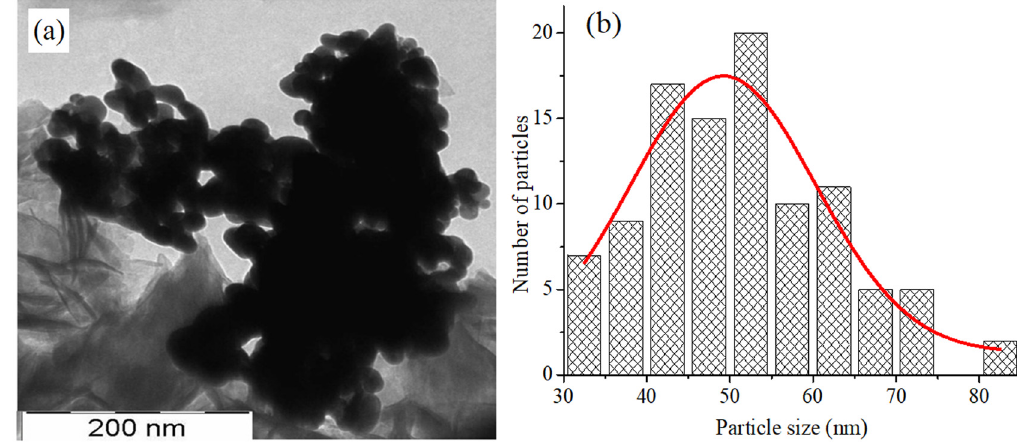
Figure 9: ( a ) TEM image of NiNPs at mag. 200 nm. ( b ) Diameter distribution of 100 particles NiNPs using Image -